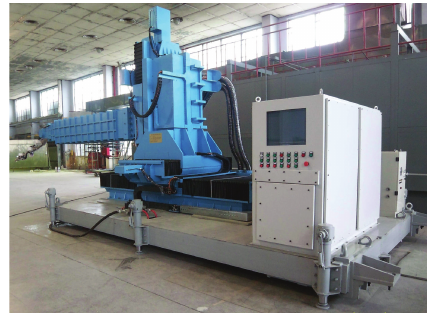
Figure 18: Painting robot.